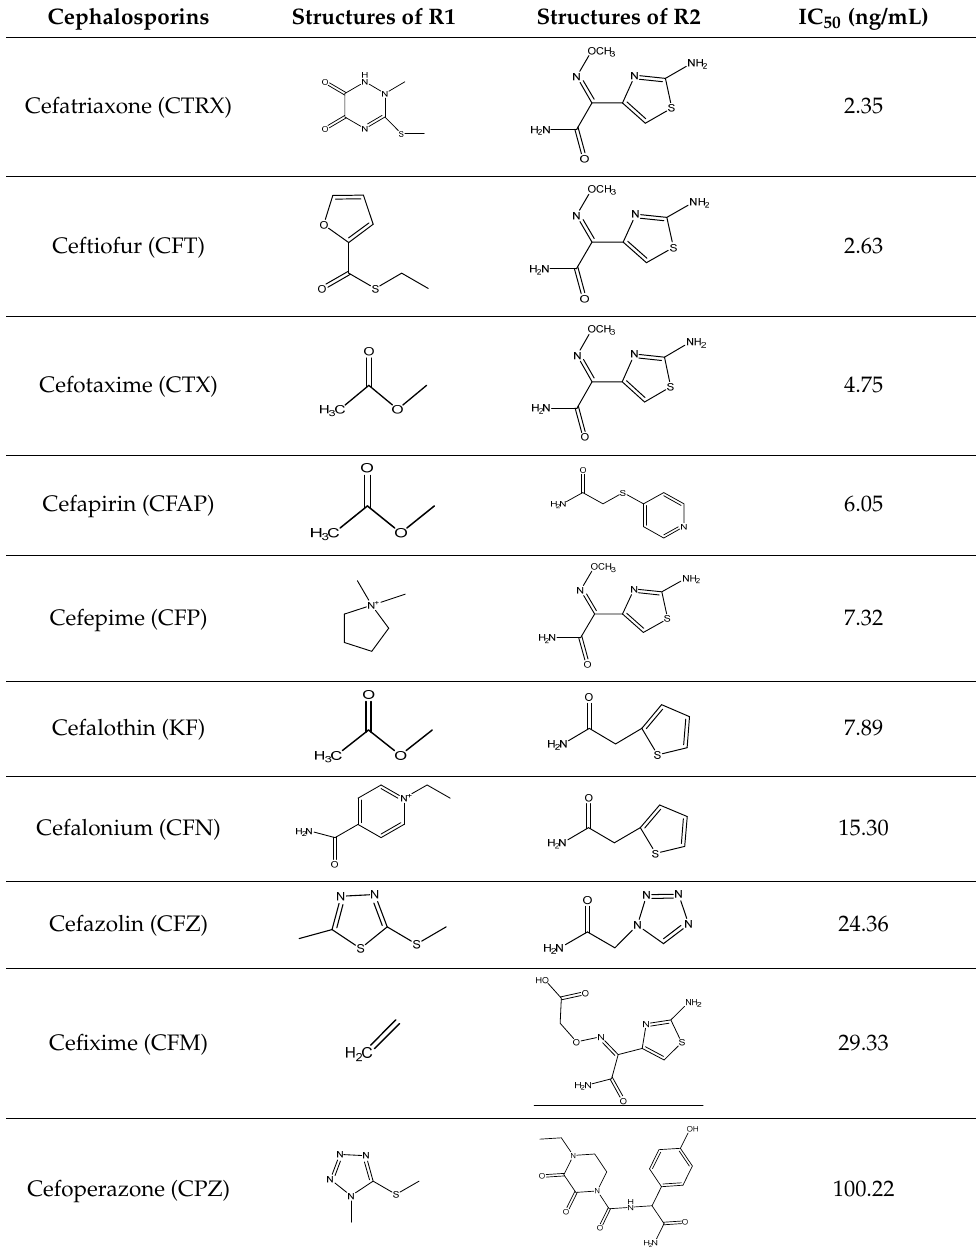
Table 2. The affinity of cephalosporins to PBP2x*. Cephalosporins Structures of Cephalosporins Structures of R1